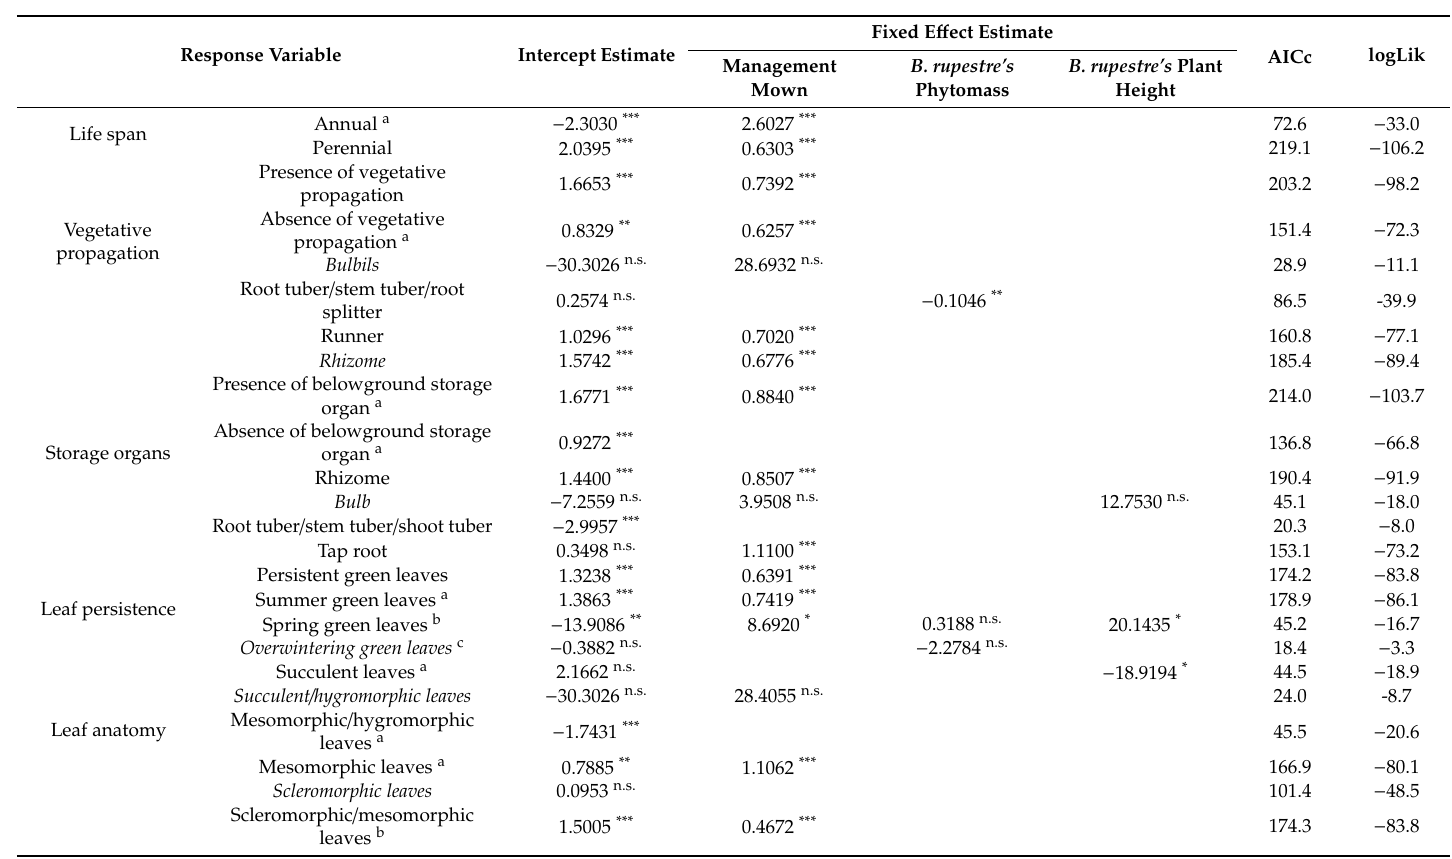
Table 2. E ff ect of management (mowing / abandonment), Brachypodium rupestre plant height and aboveground phytomass (fixed e ff ects) on the traits of species in the plant community (frequencies). A preliminary model selection was run on the full models fitted using generalized linear mixed-e ff ect models with Poisson error distribution and block identity as the random intercept, through an Akaike Information Criterion-based (AICc) procedure. The reduced models were fitted using penalized quasi-likelihood generalized mixed-e ff ect modelling with the same error distribution and random structure, accounting for autocorrelation of residuals. Model parameters (intercept and fixed e ff ect estimates) were obtained after reduced models refitting using di ff erent correlation structures to account for autocorrelation, and selecting the model with the least correlated residuals. The correlation structures are indicated with a superscript. Trait states whose model residuals are in any case correlated are in